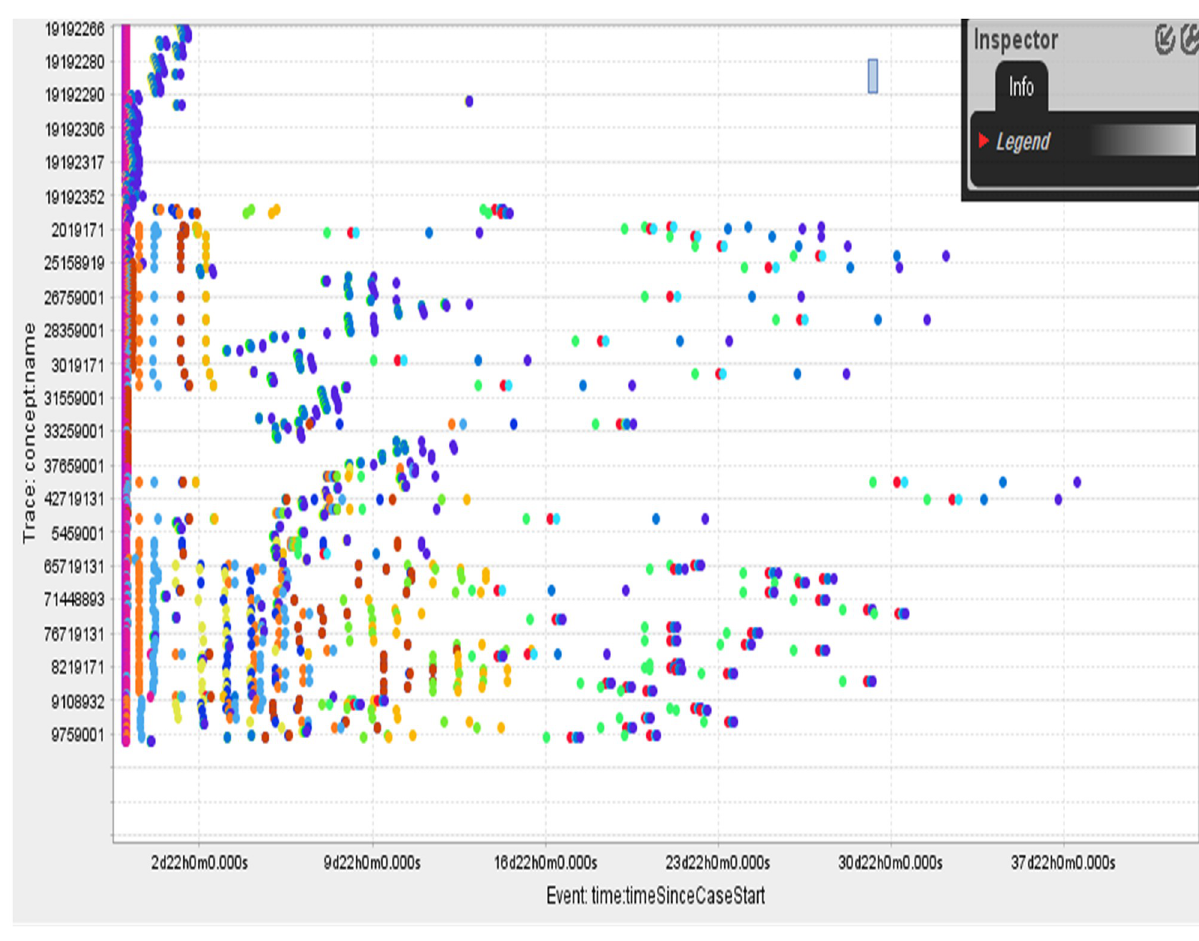
Fig 25. The dotted chart of cluster 2 of “open heart